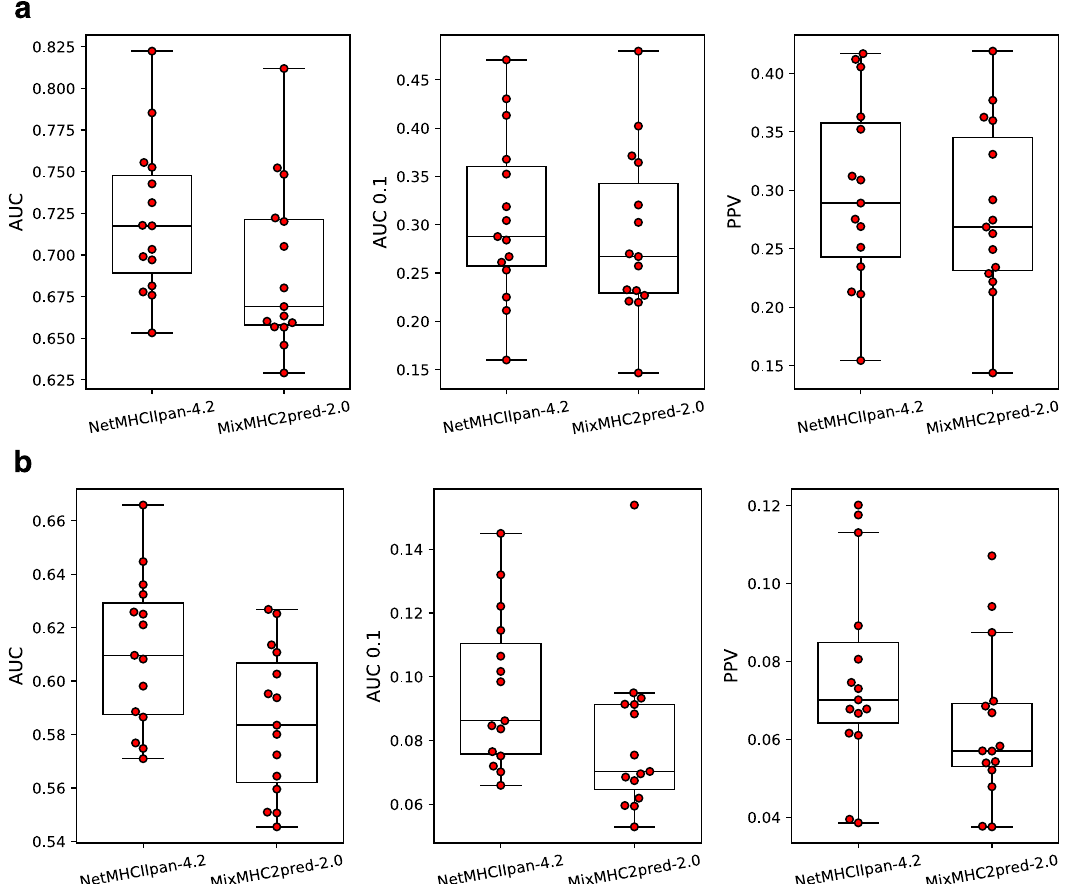
Fig. 6 Benchmark against MixMHC2pred-2.0 in terms of AUC, AUC 0.1 and PPV. Predictions were made without peptide context encoding in both methods. Each point is the performance metric for a given sample. Each boxplot ( n = 15 samples in all cases) shows the median inside the IQR between the upper and lower quartiles, with whiskers extending to at most 1.5 times the IQR. a Performance per sample calculated on the entire data. b Performance per sample calculated on the union of DQ-annotated peptides between the two